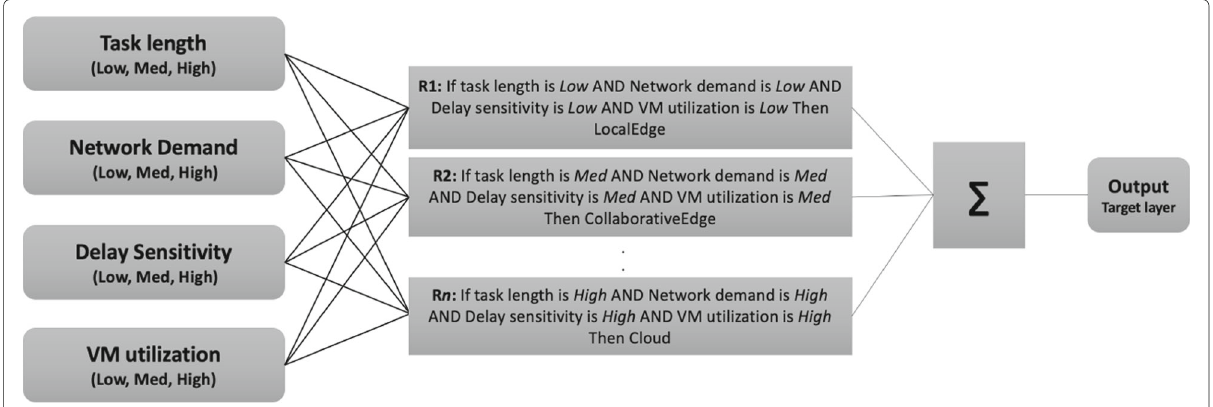
Fig. 3 Process of the proposed fuzzy logic